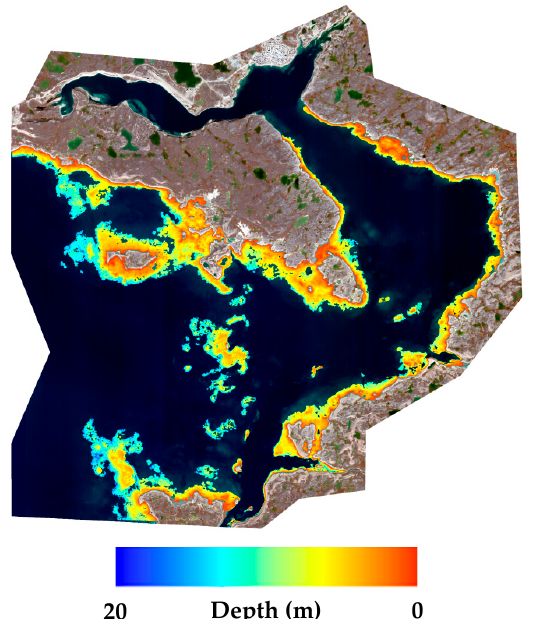
Figure 8. Overview of the multi-approach SDB results. Imagery © 2015, DigitalGlobe, Inc.